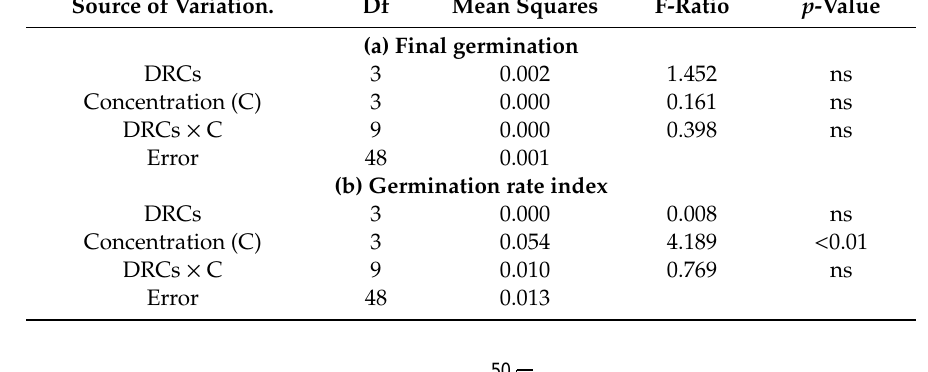
Table 3. Results of ANOVA showing the e ff ects of dormancy regulating compounds (DRCs) at various concentrations on final germination and the e ff ect of husk treatment and temperature on the germination rate index of Brachypodium hybridum . ns: insignificant di ff erence at p ≤ 0.05. Source of Variation.